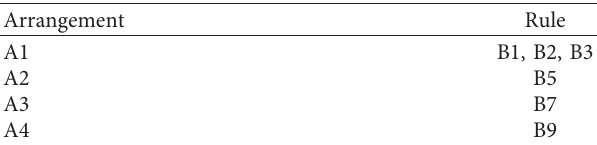
Table 3: Rules after